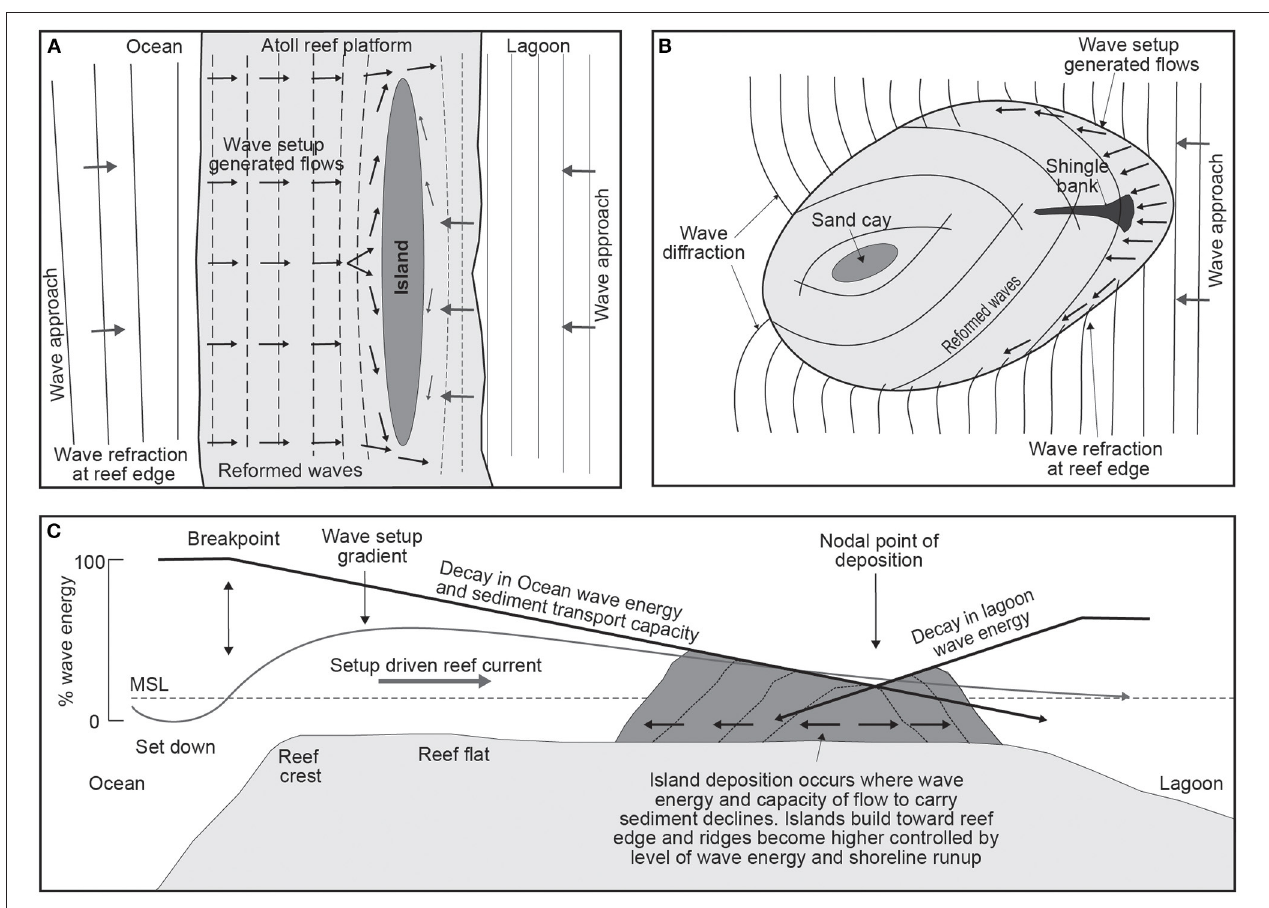
FIGURE 7 | Conceptual models of wave interaction with reef platforms, resultant current gradients and controls on island formation. (A) Wave interaction with a linear atoll reef rim. (B) Isolated reef platforms where wave energy can refract around the platform. (C) Idealized ocean-to-lagoon cross-section showing the decay in wave energy and generation of wave setup driven currents across reef flats. The decay in wave energy and current energy reduces the capacity to transport sediment, providing an envelope for the accumulation of sediments at nodal points on reefs (islands). As islands build toward reef the edge they accrete vertically in response to increased wave energy and runup